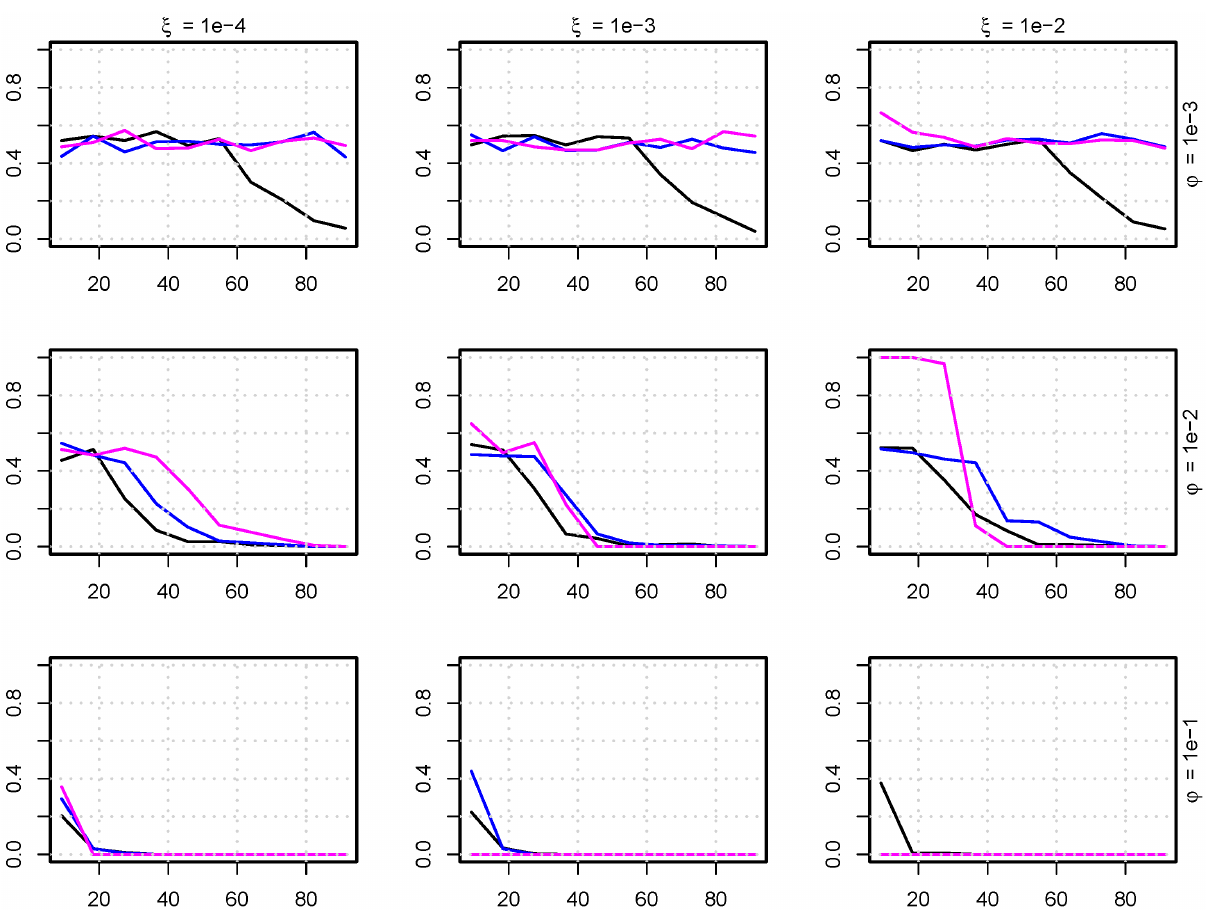
Figure 8. Survival of fitness reduced bacteria. The fraction of pigs that has survival of the strain ( S i ~ 1, j w g ) (y-axes) with a percentage reduction in growth rate compared to the mean growth rate (x-axes). The colors indicate the extinction cut off, g , under which bacteria risk extermination from the pig: pink= 10 { 6 C , blue= 5 : 10 { 5 C , black= 10 { 3 C , where C is the carrying capacity of the system ( C ~ 10 10 ). This is modeled for nine parameter sets of Q (excretion rate) and j (uptake fraction from the environment). For example, for j ~ 10 { 2 , Q ~ 10 { 2 at all three cut off values, g , the (resistant) strains are only extinct when the fitness cost is approximately 40%. ( n S ~ 10 , n R ~ 10 ).